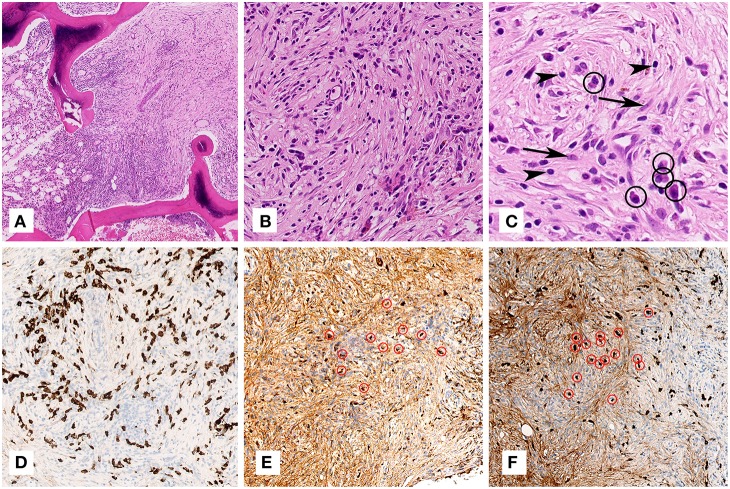
Microscopic examination of the lumbar vertebra (biopsy). (A) On overview, the marrow in between the bony trabeculae shows a quite sharp demarcation between normal bone marrow (one third on the left) and the fibrotic lesion (two thirds on the right) (H&E staining, 79x magnification). (B) Higher magnification of the lesion shows fibrosis rich in fibroblasts and arranged in a somewhat storiform fashion with admixed plasma cells and lymphocytes (H&E staining, 400x magnification). (C) Highest magnification shows several fibroblast (arrows), plasma cells (encircled) and lymphocytes (arrow heads) (H&E staining, 800x magnification). (D) Immunohistochemistry for CD138 shows in dark brown the numerous plasma cells (CD138 immunohistochemical staining, 400x magnification). (E,F) Immunohistochemistry for IgG (E) and IgG4 (F) shows in dark brown numerous IgG and IgG4 positive plasma cells, respectively, some of which encircled in red (IgG and IgG4 immunohistochemical stainings, 200x magnification).